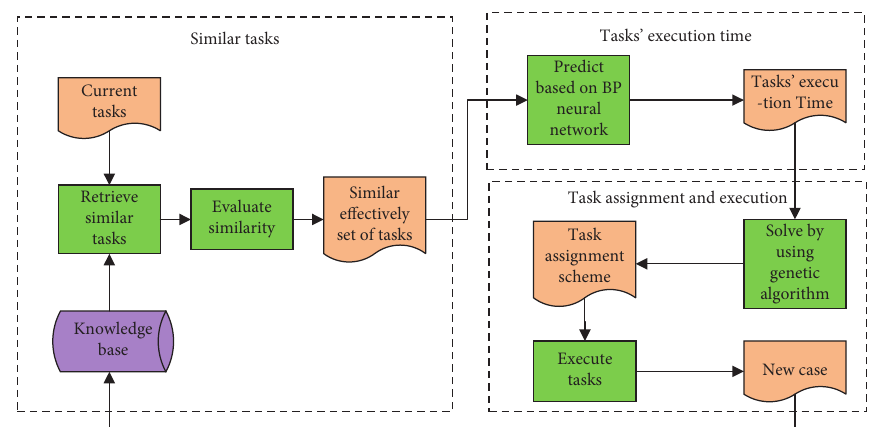
Figure 1: The efficient task assignment method system for product